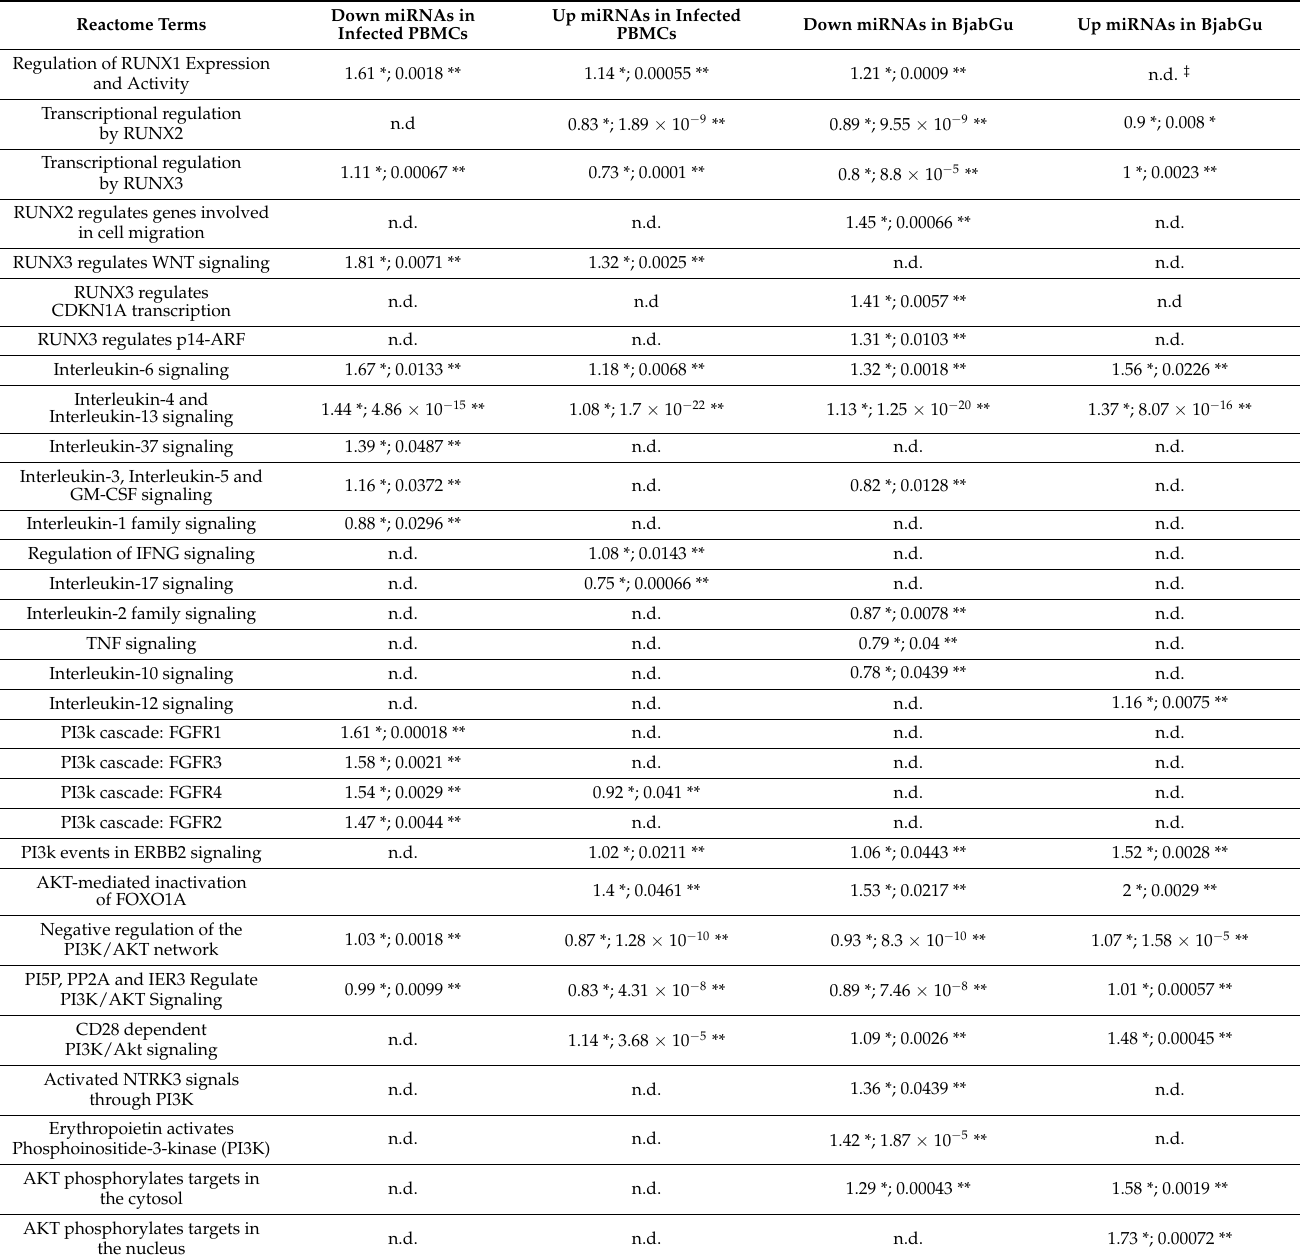
Table 1. Comparative analysis of selected signaling pathways gathered from the Reactome